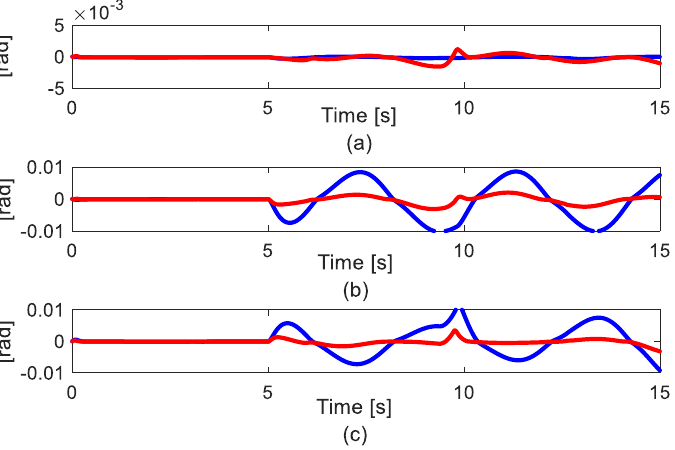
Figure 3. Tracking error results. Blue line is [30]+ESO controller. Red line is the proposed controller. ( a ) Joint 1; ( b ) Joint 2; ( c ) Joint (3).